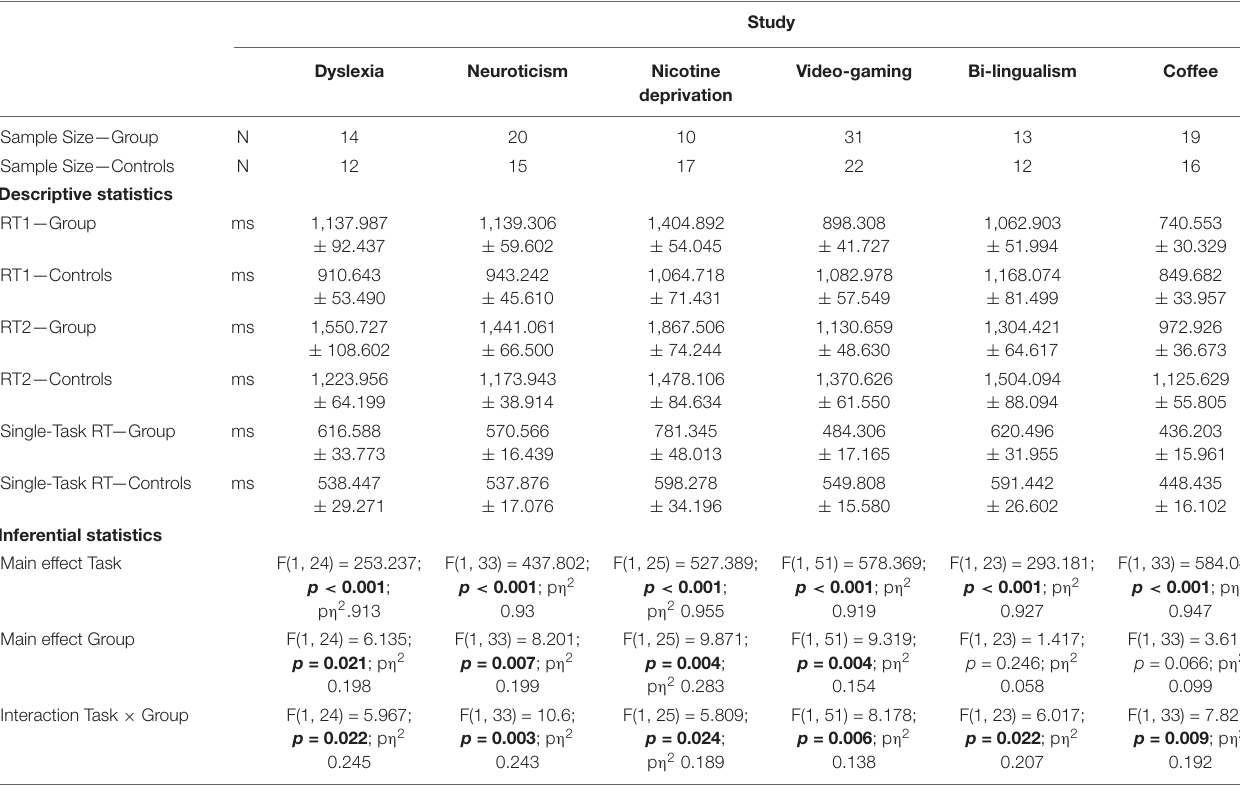
TABLE 2 | Descriptive and inferential statistics of response times in Experiment Series 1.